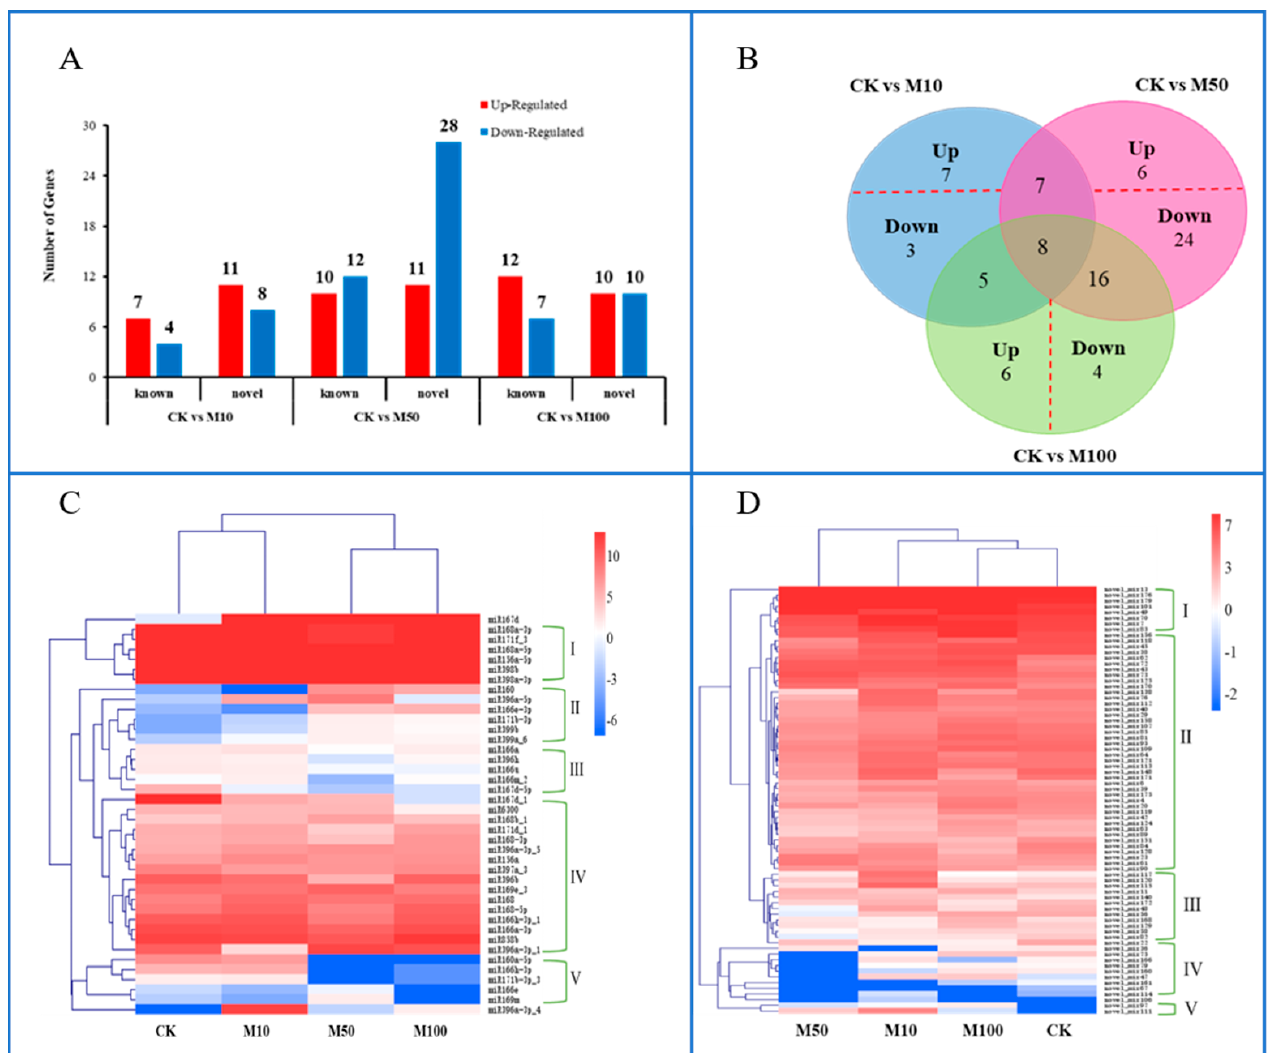
Figure 4. Differently expressed miRNAs in CKvsM10, CKvsM50, and CKvsM100. ( A ) the numbers of miRNAs up or downregulated in the CKvsM10, CKvsM50, and CKvsM100 (>1.5-fold and p < 0.05); ( B ) A Venn diagram representing the unique and common regulated miRNAs in the CKvsM10, CKvsM50, and CKvsM100; ( C ) Differentially expressed known miRNAs in response to MeJA. From the red to the blue corresponds to the numerical value of log2(TPM) from the high to the low; ( D ) Differentially expressed novel miRNAs in response to MeJA. From the red to the blue corresponds to the numerical value of log2(TPM) from the high to the low.